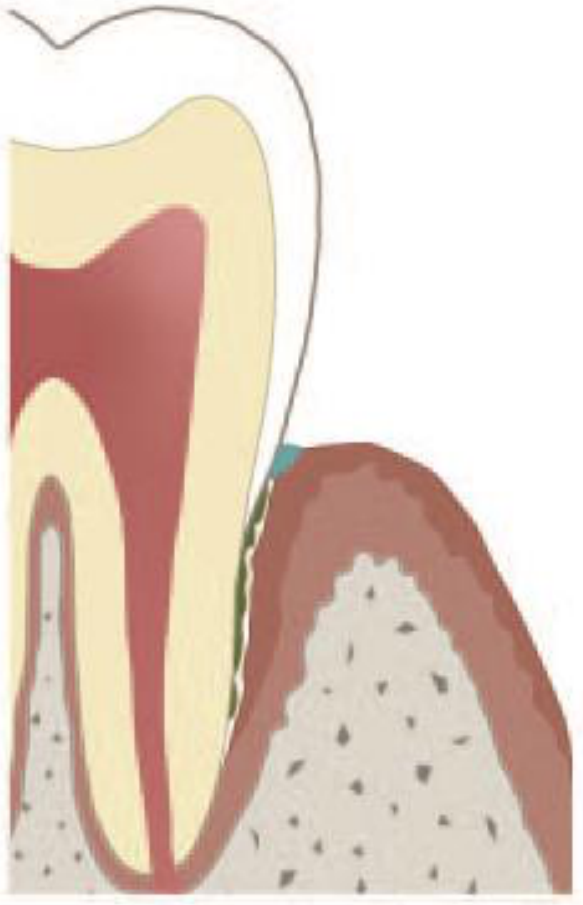
Figure 2. Occlusion of marginal pocket either by aggregated NETs (aggNETs), or by attachment of the marginal epithelium to the root. The underlying pocket epithelium continues to secrete gingival crevicular fluid, and polymorphonuclear neutrophils (PMNs) continue to transmigrate. The exact nature of the plug (depicted blue) has not been clarified yet [87,113].